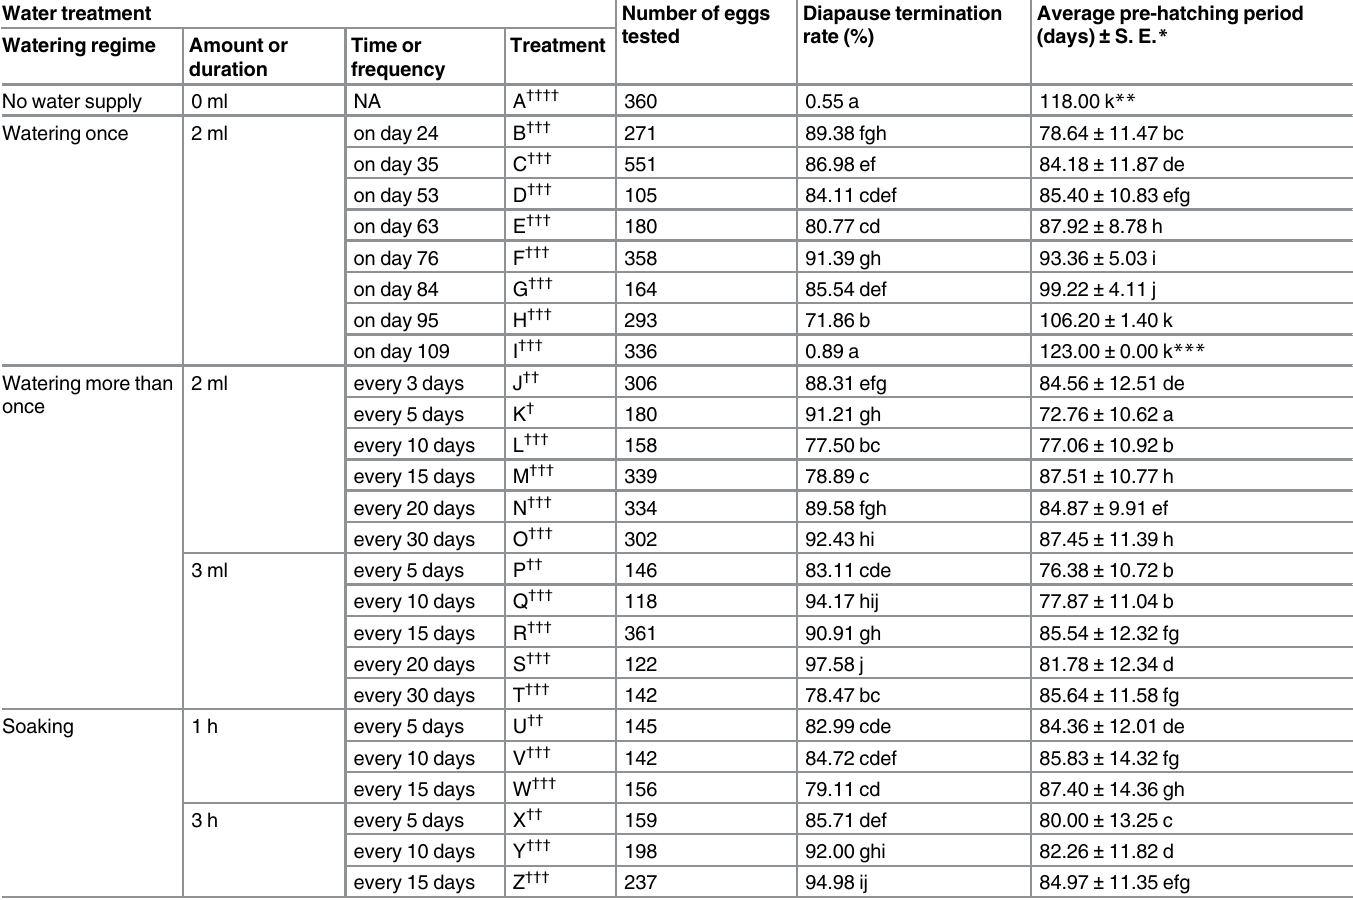
Table 1. Diapause termination rate and average pre-hatching period for diapausing eggs of A . lucorum exposed to different water treatments under warm long day